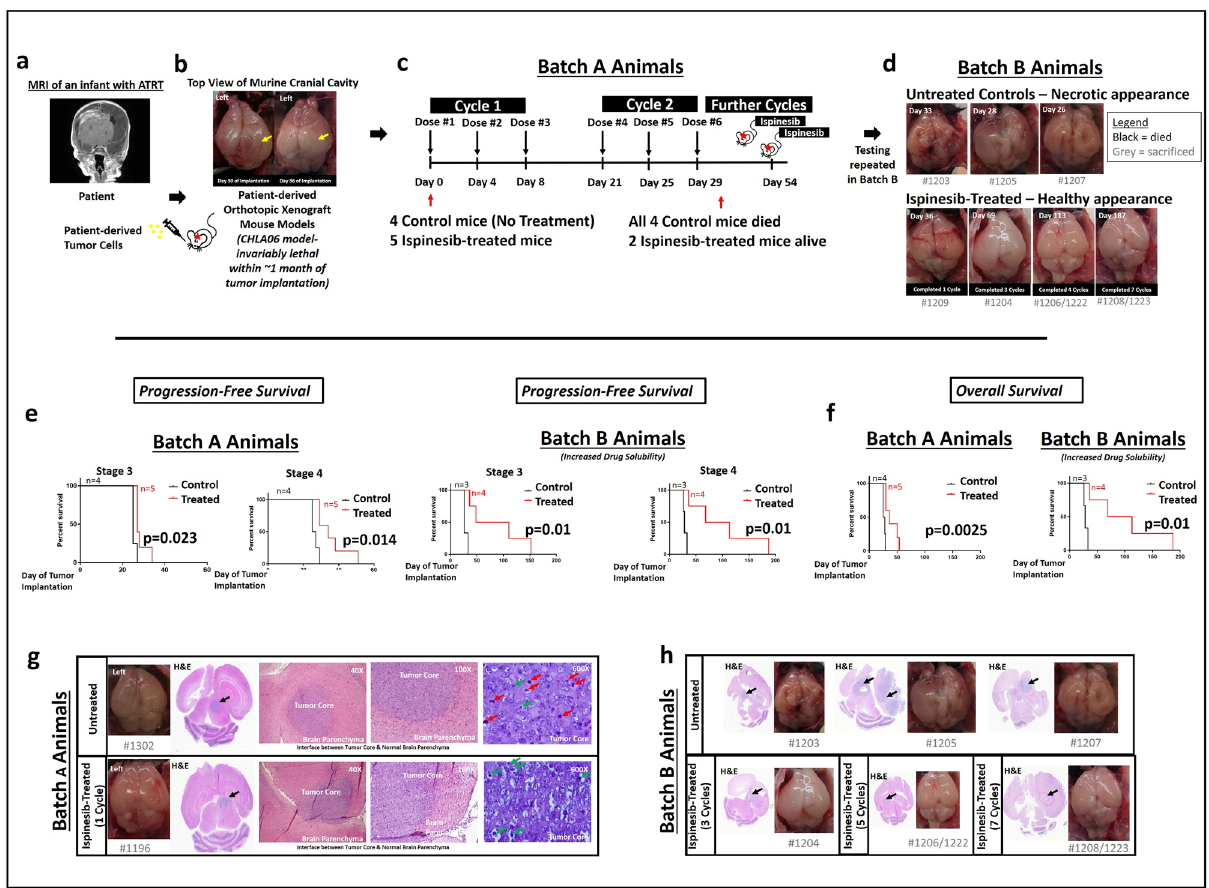
Figure 2. Ispinesib is a promising therapy for atypical teratoid rhabdoid tumor. ( a ) Coronal section of magnetic resonance imaging (MRI) of an infant with atypical teratoid rhabdoid tumor (ATRT). ( b ) Top view of cranial cavity of different mice implanted with CHLA-06 tumor cells into the right cerebrum ( yellow arrows highlight the bulging right brain with tumor growth beneath). ( c ) Treatment timeline in Batch A animals (Treatment Group = 5, Control Group = 4). Ispinesib in-vivo dosing was 10 mg/kg administered intraperitoneally every 4 days for three doses, with the treatment course repeated on day 21. ( d ) Top view of cranial cavity of mice brains in Batch B animals (Treatment Group = 4, Control Group = 3). Brains from ispinesib-treated animals ( lower panel ) were structurally more normal in appearance, in contrast to untreated control animals ( upper panel ) which were distorted by tumor growth and more necrotic in appearance. Similar findings were observed in Batch A animals (Fig. S5). ( e ) Progression-free survival of animals in both Batch A and Batch B demonstrating significantly improved survival outcome among ispinesib-treated mice (Log-rank test, Mantel- Cox method). Solubility of ispinesib was increased using different diluent for reconstitution (“Materials and methods”, Batch A: Less soluble. Batch B: More soluble). ( f ) Overall survival of animals in both Batch A and Batch B similarly demonstrating significantly improved survival outcome among ispinesib-treated mice (Log- rank test, Mantel-Cox method). ( g ) Hematoxylin and eosin (H&E) staining of formalin-fixed mouse brains (ispinesib-treated versus untreated control, Batch A animals). Coronal sections of mouse brains from ispinesib- treated versus untreated mice showing a tumor mass ( black arrows ) in the center compressing against normal brain tissue. Magnification (×40 and ×100) photomicrographs showing tumor core interfacing with normal brain parenchyma in mice brains. Magnification (×600) photomicrographs showing ispinesib-treated tumors demonstrating frequent apoptotic bodies ( green arrows ) but no mitoses ( red arrows ). In contrast, untreated control xenograft tumors demonstrated numerous mitoses ( red arrows ) and a small number of apoptotic bodies ( green arrows ). ( h ) H&E Coronal sections of ispinesib-treated versus untreated control (Batch B animals). Black arrows indicate tumor. Absence of a visible tumor in mouse which received 7-cycles of ispinesib. Effects were tumor-specific; surrounding mouse brain parenchyma remained healthy with normal appearance, after 7 cycles of